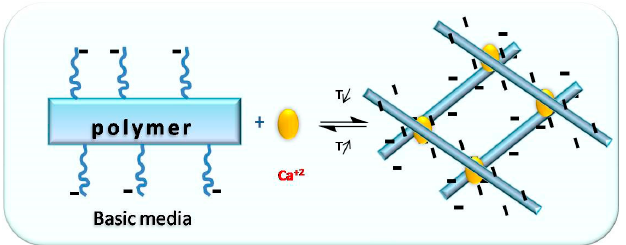
Figure 6. ( a ) UV–vis spectra of PDTriG (pH = 10, 0.5 mg/mL) on addition of CaCl 2 (1:1 equivalents) in